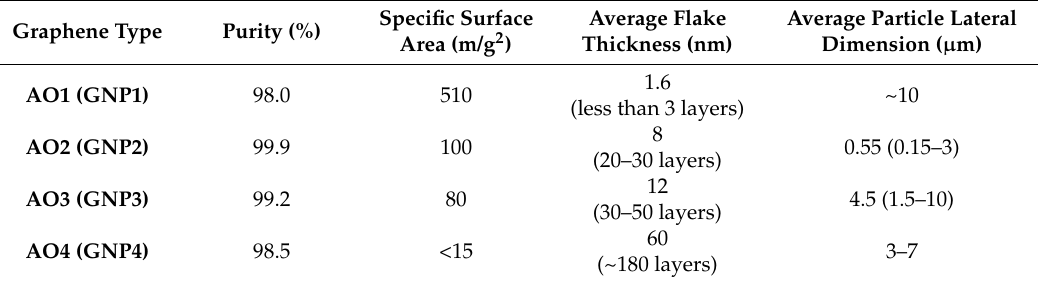
Table 1. Main geometric characterizes of graphene